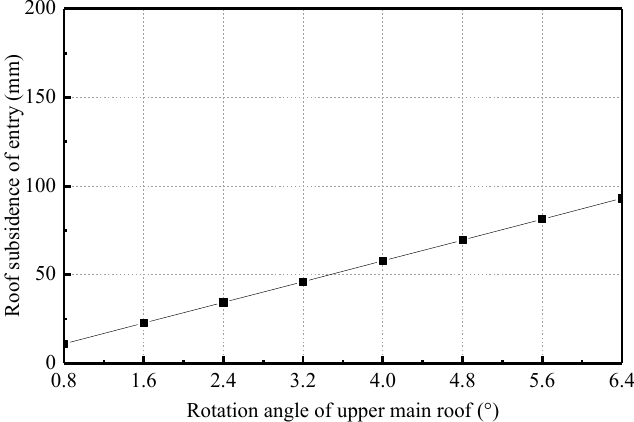
Figure 4. Relationship between roof subsidence and the rotational angle of key blocks.